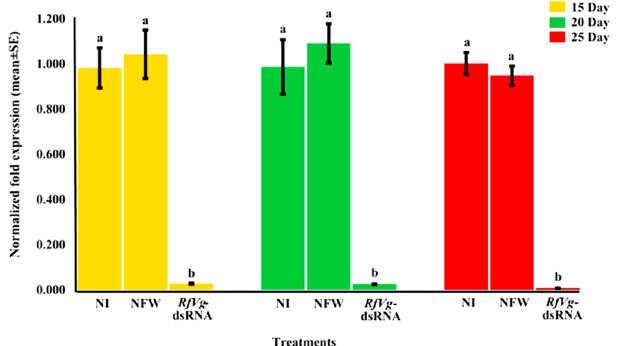
Figure 3. The RNAi-based silencing of RfVg gene results in significant down regulation of Vg gene. Expression levels of the RfVg gene were quantified by quantitative real time PCR. Normalized fold expression of the RfVg - dsRNA-injected group were compared with no injection (NI) and nucleus free water (NFW) groups on day 15, 20, and 25 of post-injection periods. Different letters above the bars (a,b) show significant differences among the groups at (α = 0.05). The expression levels of RfVg gene were significantly reduced in RfVg -dsRNA injected group in comparison to the NI injection and NFW injected groups. All biological groups contained three replicates. Each replicate has a single animal, while there were three technical replicates.